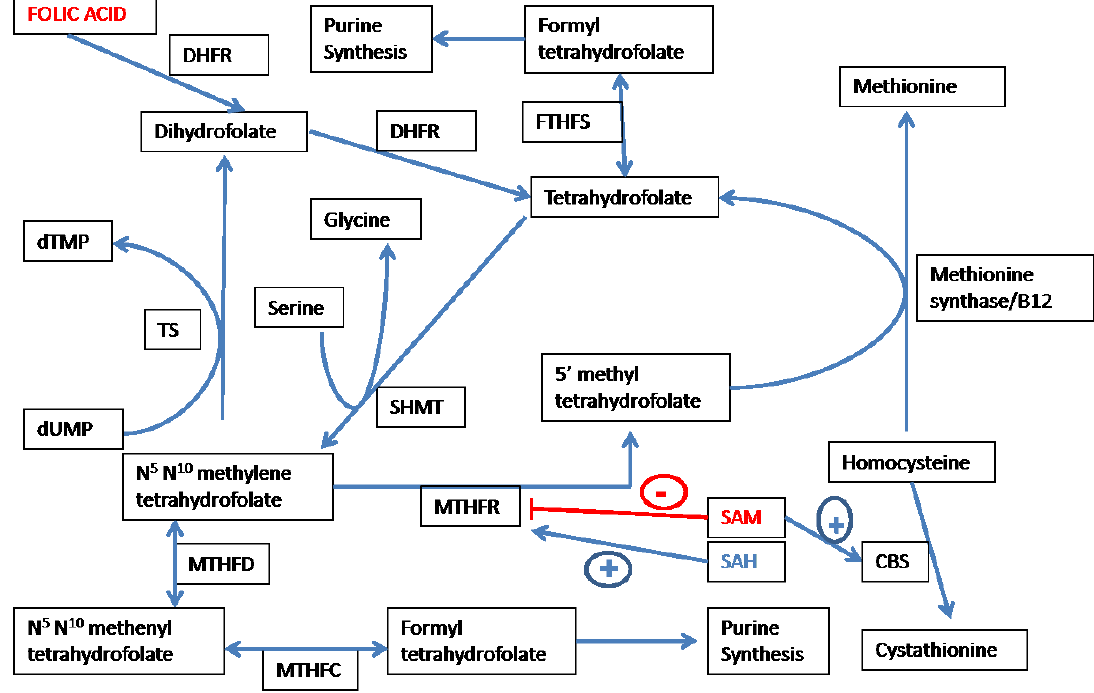
Figure 2. Folate metabolism and methionine-homocysteine cycle. Abbreviations: reducatse; SHMT—serine